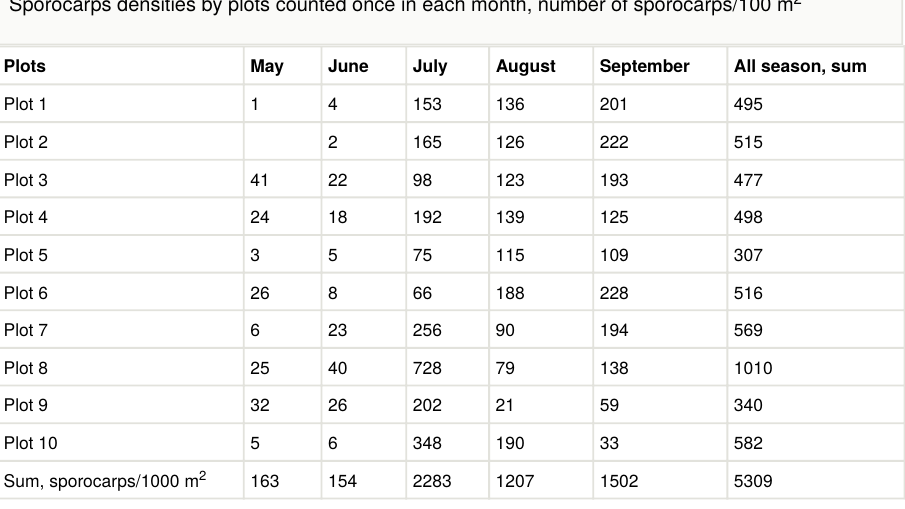
307 and 340 sporocarps/100 m /season respectively. The sporocarps density of seven other plots was approximately 500/100 m